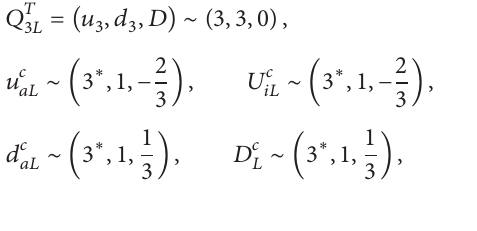
Figure 1: Generation of the neutrino masses via the one loop radiative mechanism in the 3-3-1 model with exotic